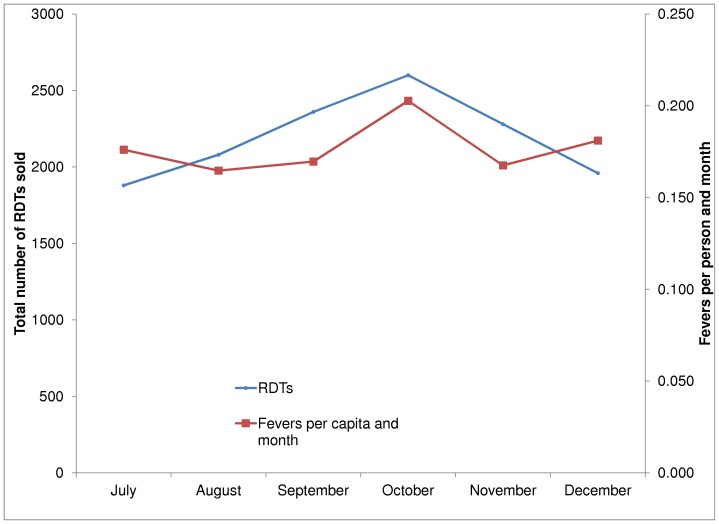
Trends in RDT Sales and Fevers.